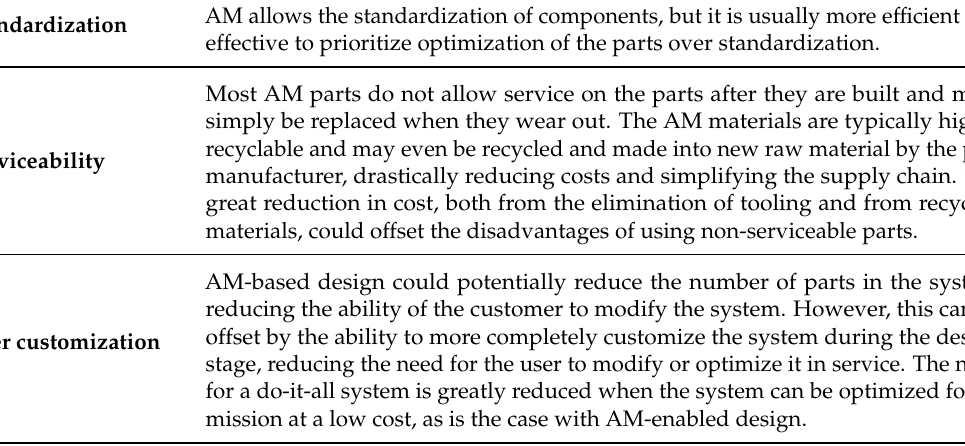
Table 2. Modular principles directly affected by the combination-of-functions approach.